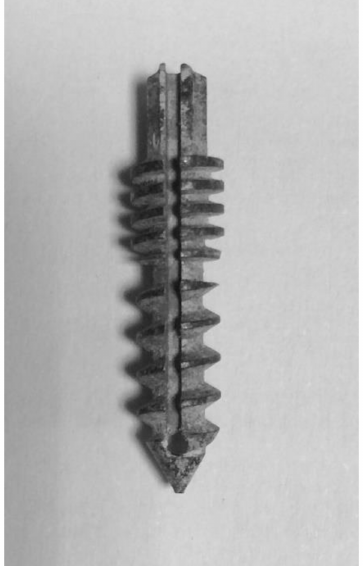
Figure 4. Prototype of the suture anchor manufactured using CNC machining.